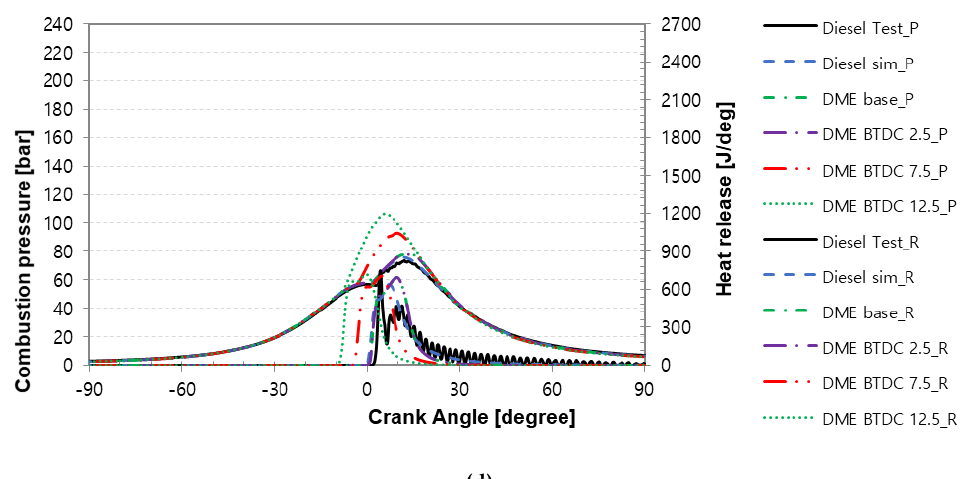
Figure 3. Combustion and heat release characteristics versus start of injection timing for marine diesel fuel and dimethyl ether (DME) fuel: ( a ) 100% load; ( b ) 75% load; ( c ) 50% load; ( d ) 25% load.